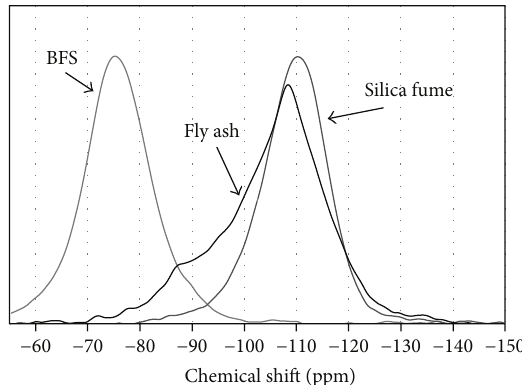
Figure 2: 29 Si NMR spectra of raw